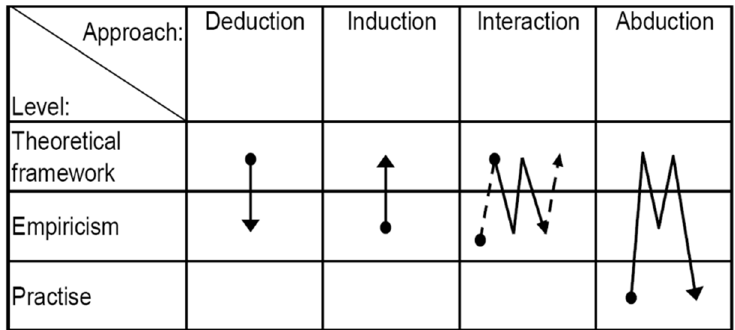
Figure 4. Comparison and presentation of different research methods. (Lindqvist, 2011) [34].